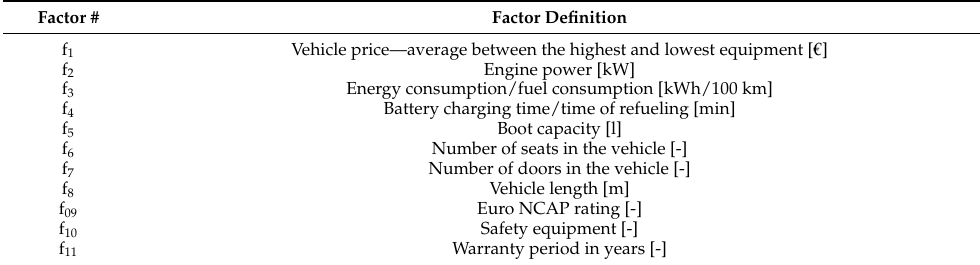
Table 2. Factors considered in the analysis of selecting carsharing fleets.